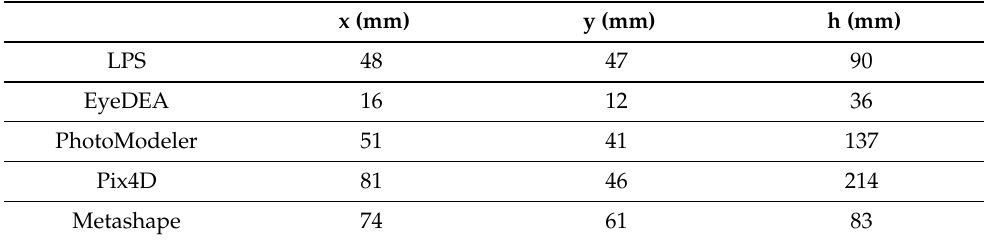
Table 2. CP RMSE values obtained for each software. Adapted from